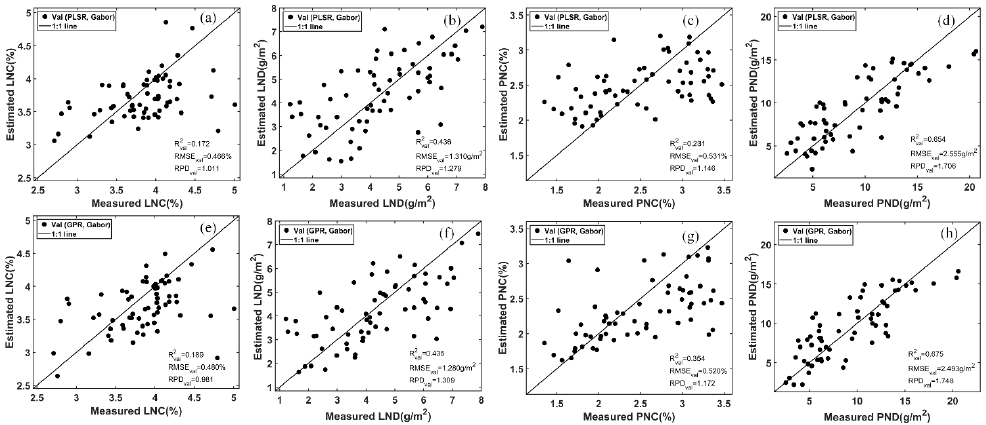
Figure 11. The predictive performance of ( a – d ) the PLSR and ( e – h ) GPR models based on the Gabor-based textures for winter wheat N status estimation.